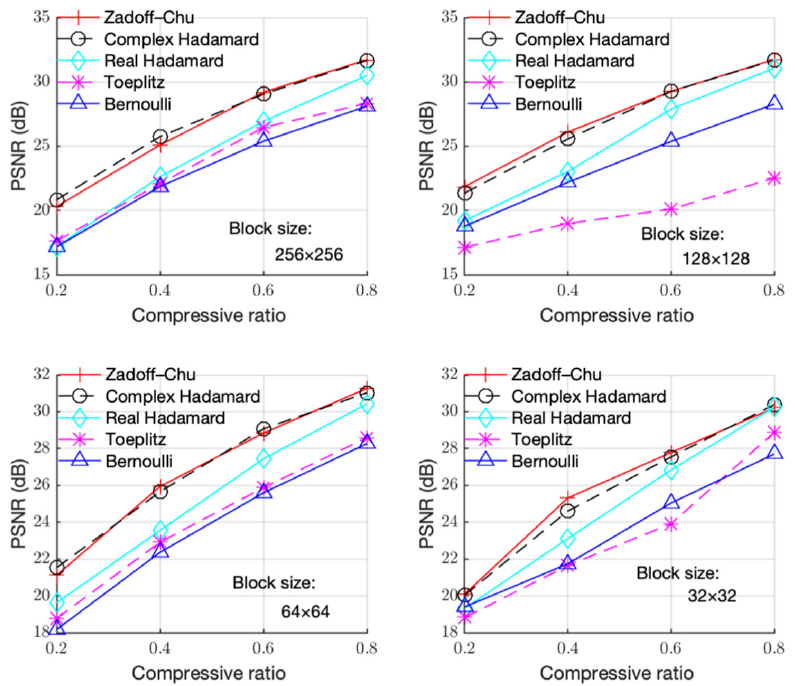
Figure 5. PSNR with CR under different block sizes for the “House” image.